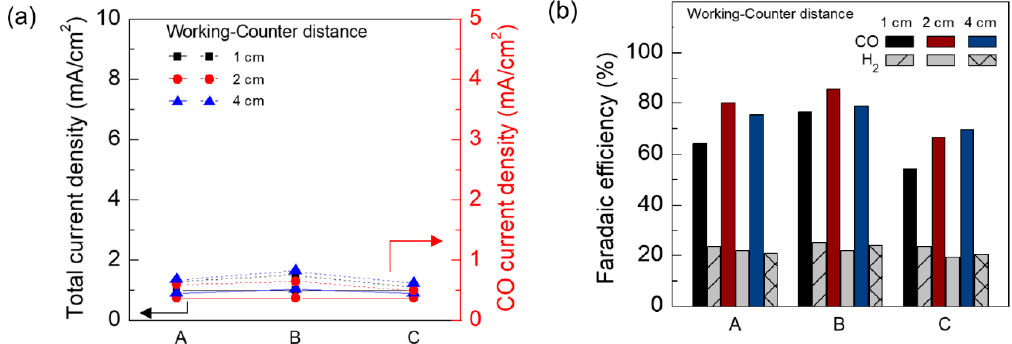
Figure 7. ( a ) Total electrolysis current density and CO production current density of the 25.5 cm 2 Ag GDE according to the position and ( b ) the corresponding FE for CO and H 2 . Ag deposition was performed at 0.83 mA/cm 2 for 5 min with different working-counter electrode distances: 1, 2 and 4 cm. The CO 2 reduction was performed at a constant voltage of − 1.5 V (vs. SCE) in a laboratory-made H-type cell. 0.5 M KHCO 3 was used for both the anolyte and the catholyte.